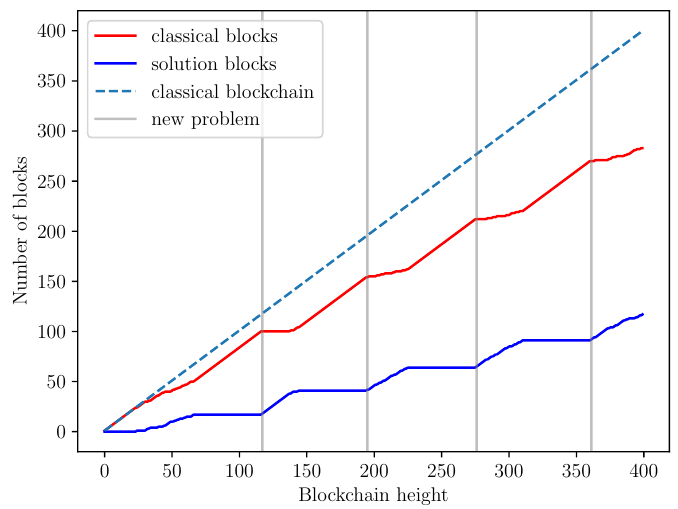
Fig. 2. Number of classical (red) and solution blocks (blue) mined as a function of the blockchain height using the simulations described in Section 3. The dashed line represents the number of classical blocks mined on a classical blockchain (such as Bitcoin) as a function of the blockchain height. We have also replaced the problem in the network by a new one once the best score saturates. The introduction of a new problem is represented by the gray = t r = 0 . 1 s . The update frequency for solution vertical lines. We use protocol DIPS with t b 2 2 = 10 and N r = 5 since at early stages of the problem, solutions are found blocks is set to N b 2 2